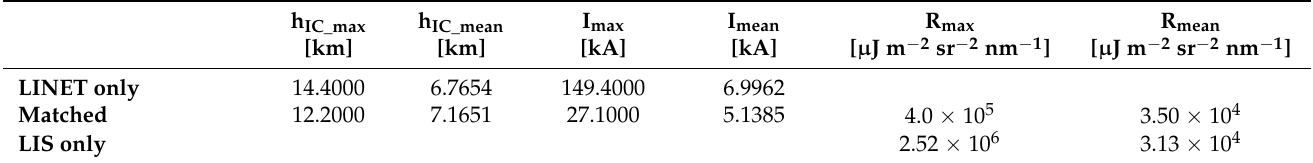
Table 3. Summary of the characteristics for flashes observed by LINET, LIS, and